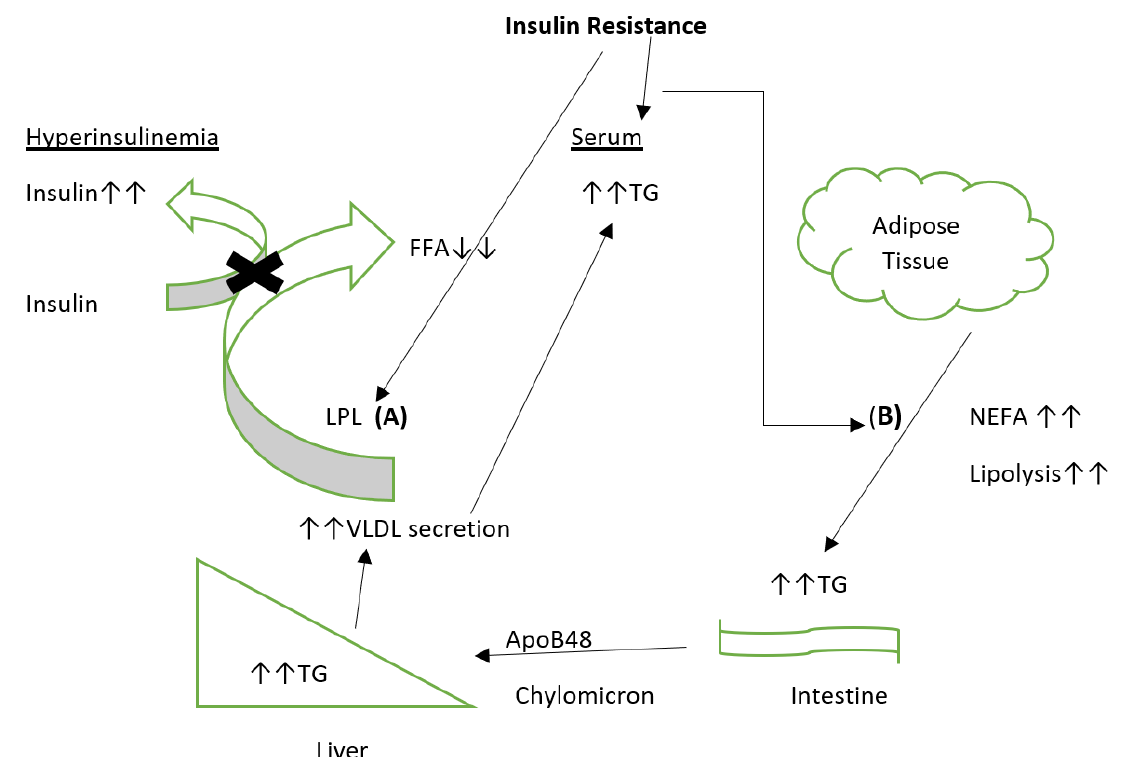
Figure 1. Insulin resistance leads to the diminished capacity of lipoprotein lipase (LPL) to metabolize very low-density-lipoprotein (VLDL) and other triglycerides (TG) rich particles to free fatty acids (FFA). It ultimately results in increased serum triglycerides because of blunted LPL activity ( A ). Chronic hyperinsulinemia facilitates VLDL production in states of insulin resistance. The suppressive effects of insulin are lost in insulin-resistant conditions, e.g., obesity or diabetes mellitus (DM). ( B ) Insulin resistance can lead to increased nonesterified fatty acid (NEFA) production via lipolysis, resulting in increased FFA flux to the liver, leading to increased VLDL production. Additionally, Fatty acids (FA) may increase, due to increased FA trapping by insulin-resistant adipocytes. Increased serum FA is associated with stimulation of the body to produce large amounts of reactive oxygen